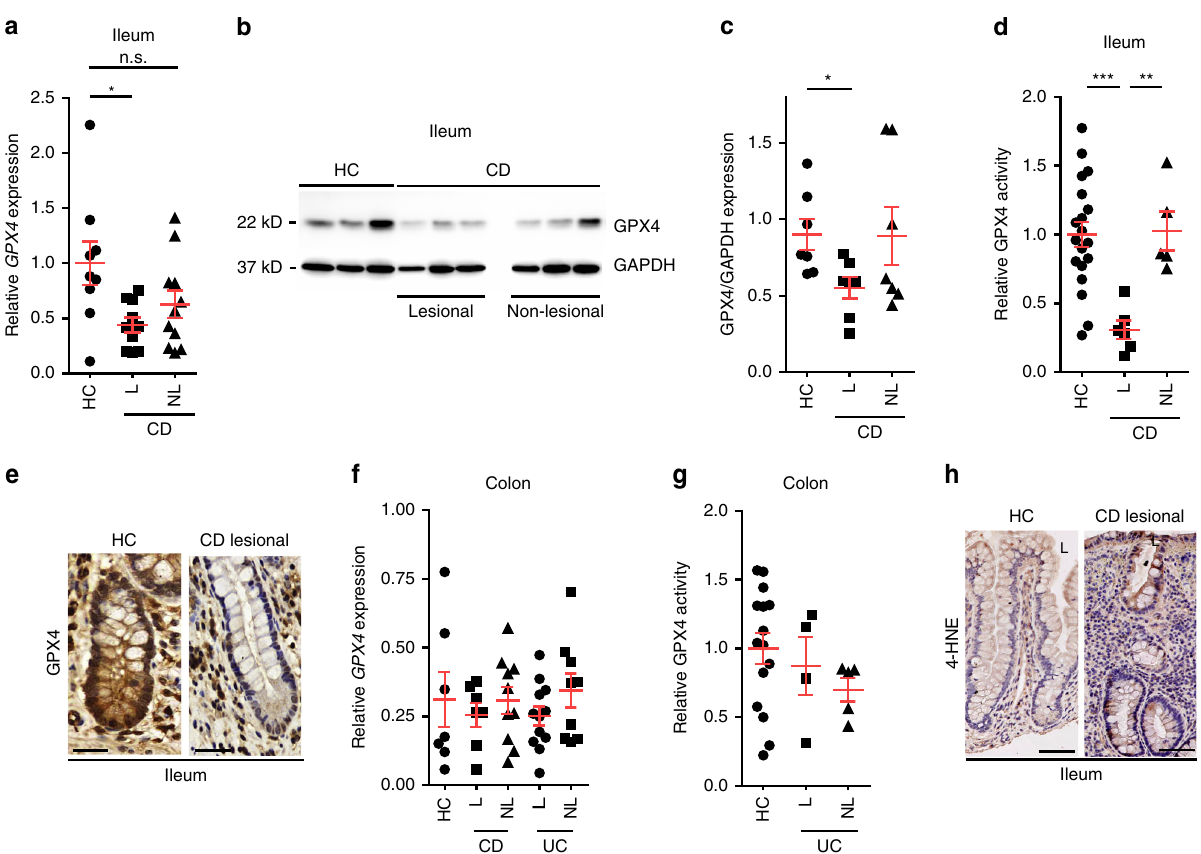
Fig. 1 Reduced GPX4 activity and LPO localize to IECs in CD patients. a Relative GPX4 expression in the macroscopically in fl amed (lesional, L) and macroscopically non-in fl amed (non-lesional, NL) small intestinal mucosa of CD patients determined by qPCR and compared to healthy controls (HC). Each dot represents one patient ( n = 9 for HC, n = 11 for CD-L, and n = 10 for CD-NL). * P = 0.0167. b , c Representative GPX4 immunoblot of IEC-enriched fractions from biopsies taken from the ileum of CD patients and HC ( b ), with densitometry relative to GAPDH shown in ( c ). Each dot represents one patient ( n = 7 patients per group). * P = 0.0265. d Relative GPX4 enzymatic activity of epithelial-enriched fractions derived from the lesional (L) and non- lesional (NL) mucosa of the small intestine of CD patients as compared to HC. Each dot represents one patient ( n = 19 for HC, n = 6 for CD-L, and n = 5 for CD-NL). *** P < 0.001, ** P < 0.01. e Representative GPX4 immunoreactivity (brown) determined in the lesional small intestinal sections of CD patients as compared to HC ( n = 7). f Relative GPX4 expression in the macroscopically in fl amed (lesional, L) and non-in fl amed (non-lesional, NL) mucosa of the large intestine of CD patients and UC patients as compared to HC. Each dot represents one patient ( n = 7 for HC, n = 9 CD-L, n = 10 for CD-NL, n = 12 for UC-L and n = 7 for UC-NL). g Quanti fi cation of GPX4 enzymatic activity in lesional and non-lesional IEC-enriched fractions from the large intestine of UC as compared to HC. Each dot represents one patient ( n = 15 for HC, n = 4 for UC-L, and n = 5 for UC-NL). h 4-HNE immunoreactivity (brown) in HC and small intestinal lesional sections of CD patients, indicative for LPO. L, luminal-oriented side ( n = 3 patients per group). Scale bars indicate 25 µ m ( e ) and 50 µ m ( h ). For panel ( a ), ( c ), ( d ), ( f ), and ( g ) data are presented as mean±SEM. One-way ANOVA with Bonferroni ’ s multiple comparison test. Source data are provided as a Source Data fi